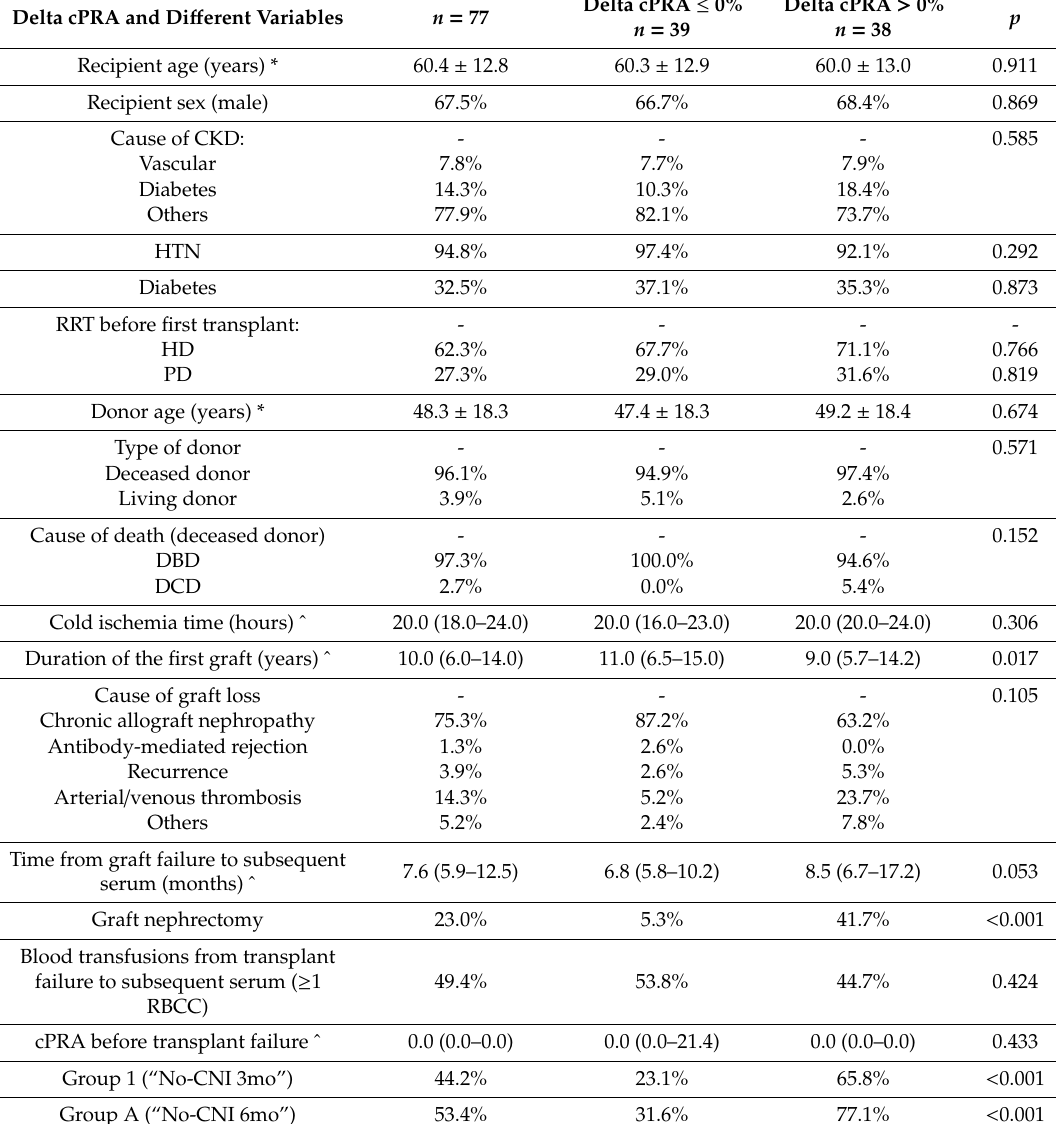
Table 5. Patient characteristics in relation to the development of delta cPRA ≤ or > 0% after transplant failure. Continuous variables were expressed as mean ± SD (*) or median and interquartile range (ˆ) according to their distribution. The bold: p values less than 0.05 defined statistical